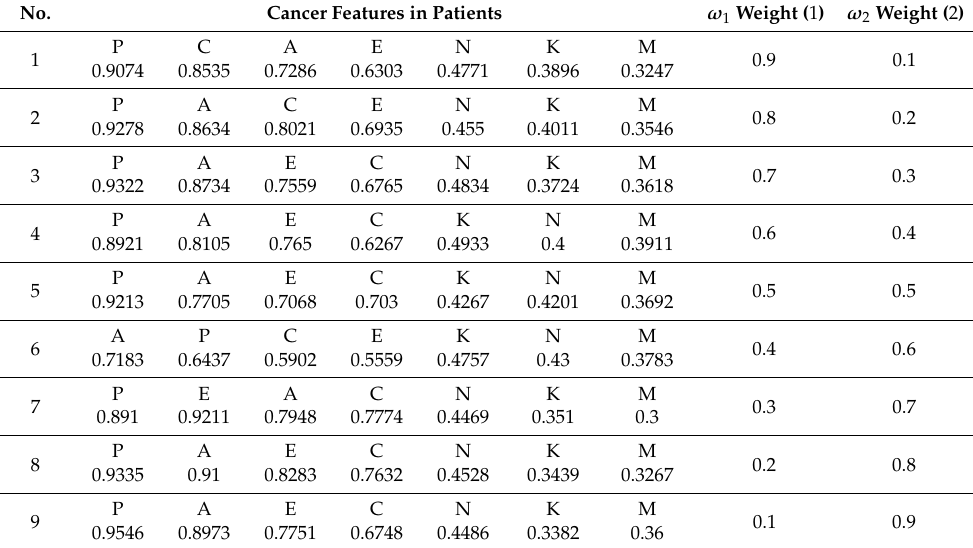
Table 3. Comparison of importance ranking of cancer features in patients for di ff erent weights in